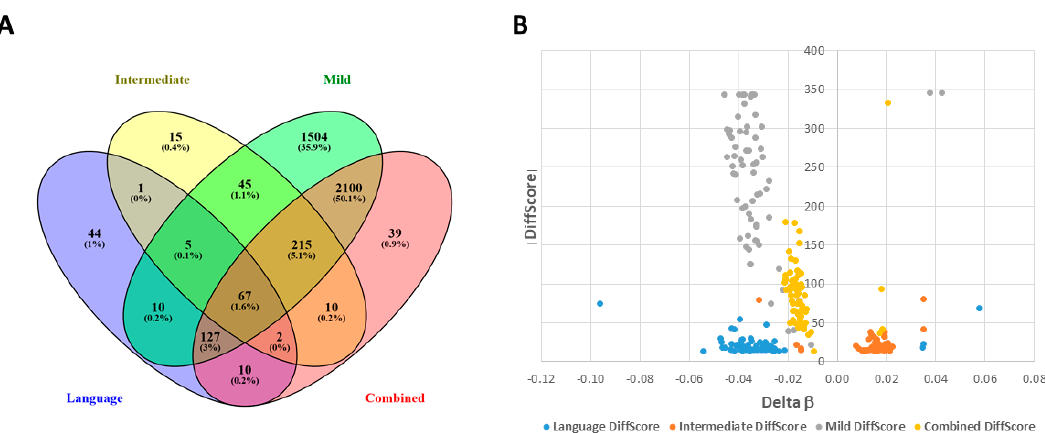
Figure 4. Stratification of ASD patients ( n = 292) into distinct subphenotypes results in increased discovery of significant DAGs. ( A ) The Venn diagram shows unique significant DAGs that were identified using GenomeStudio Methylation Module v1.8 software with subphenotyping into three groups (mild, intermediate, and severely language-impaired) or without subphenotyping (combined case group) (FDR-adjusted p -values < 0.05). ( B ) Volcano plots for the 67 overlapping DAGs from each group, identified by color in the accompanying legend.